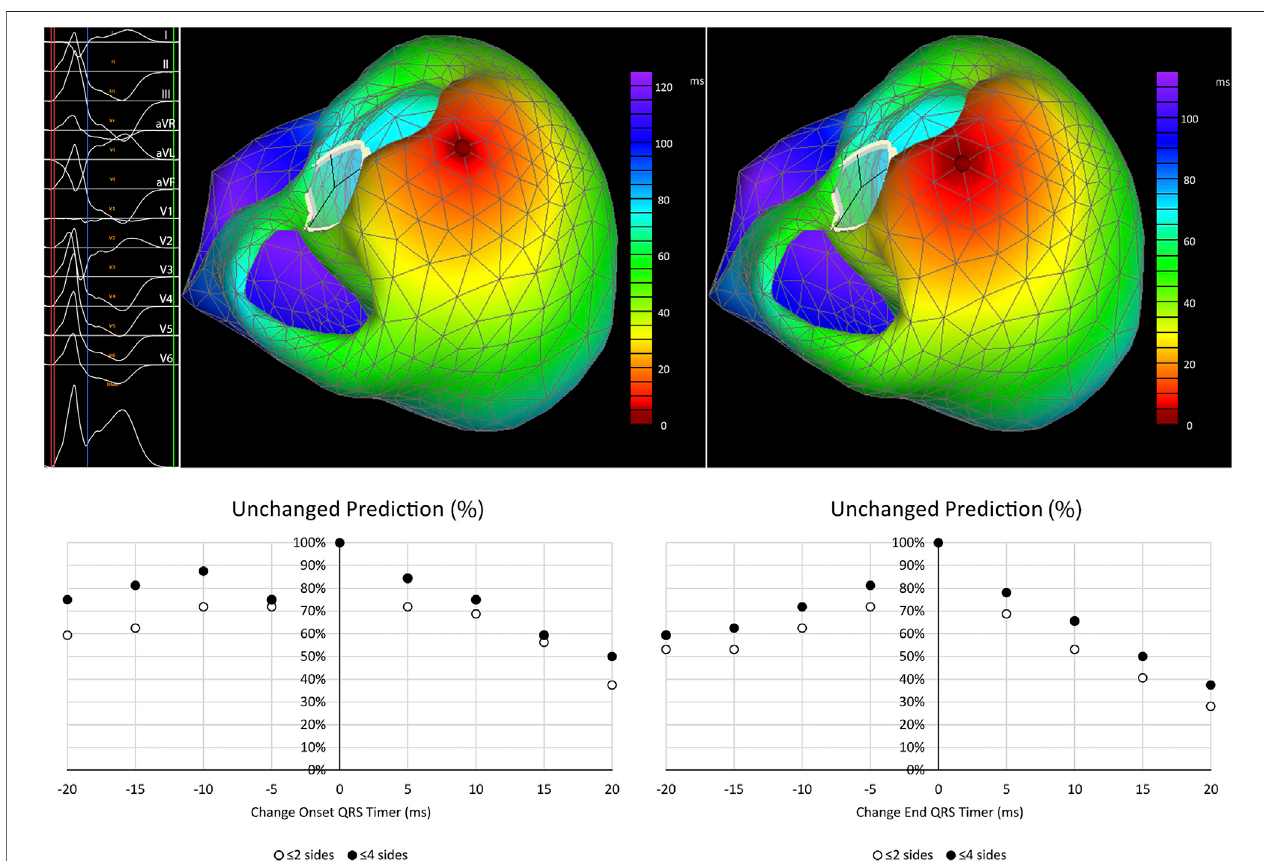
FIGURE3| Shifts inthepredicted originofPVCsinrelation tochangesintimemarkerplacement.Topleft: ECGwithtimemarkersindicating onset(red), endofthe QRS complex (blue) and an isoelectric point after the T wave (green). Top middle: Predicted activation map using standard timing placement. Top right: Predicted activation map using a delayed onset of the QRS complex (+10 ms) showing a clinically unimportant shift of one triangle side. Graphs below show the percentage of patients with clinically unchanged predictions of origin of the PVCs (de fi ned as shifts ≤ 2 or ≤ 4 triangle sides and indicated as % of cases with an unchanged prediction) before and after altering the onset (left) and end marker (right) of the QRS-complex.